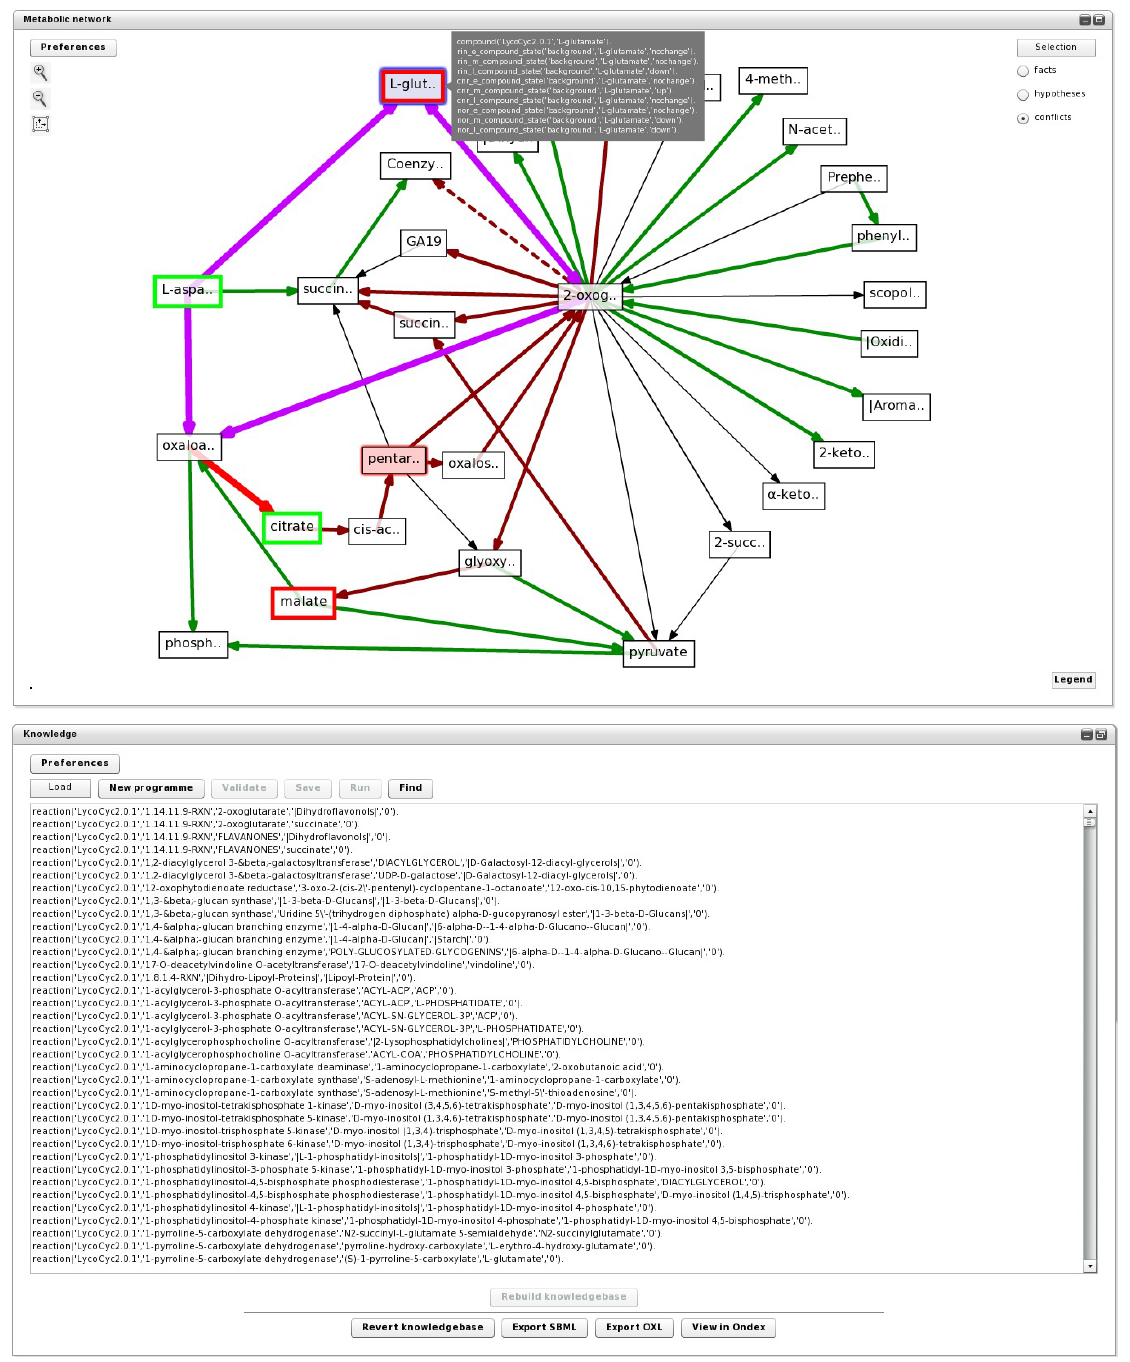
Figure 4 Top: Visualization of enzyme hypotheses; Bottom: Editor module with export features to SBML and